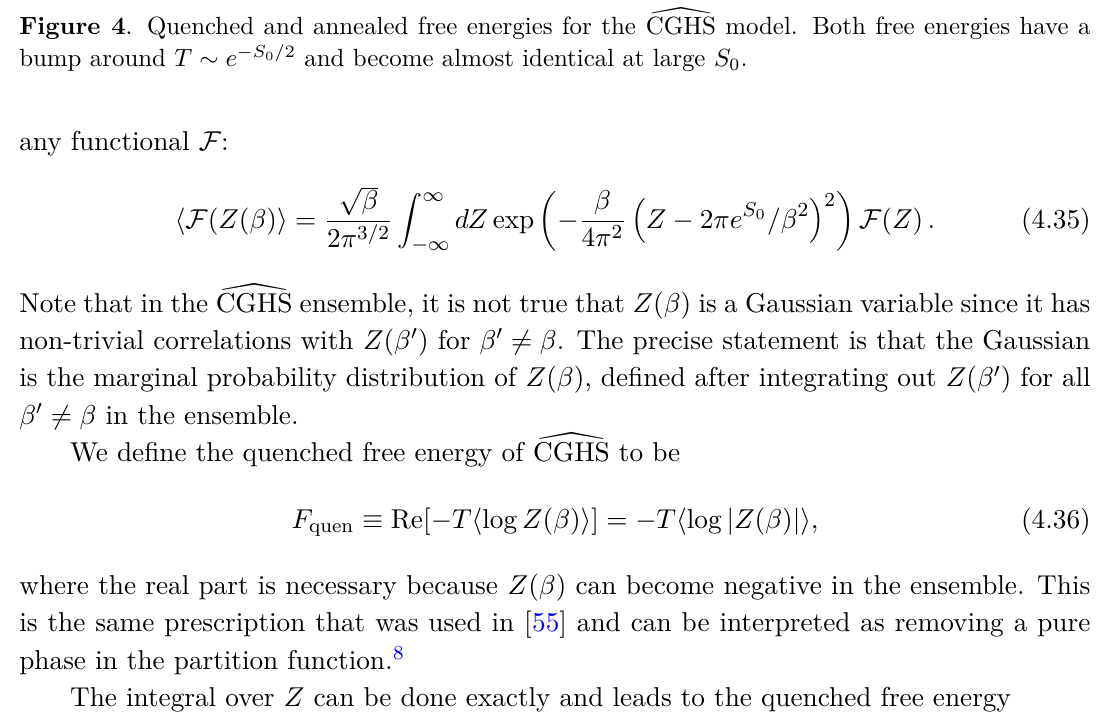
\ CGHS model. Both free energies have a